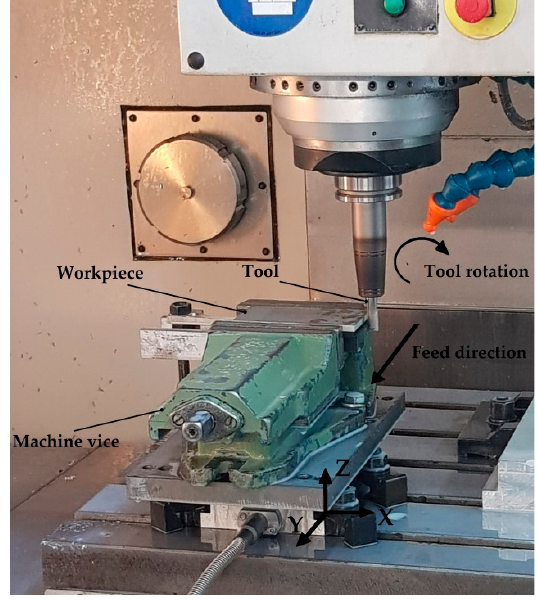
Figure 2. Scheme of cutting process.